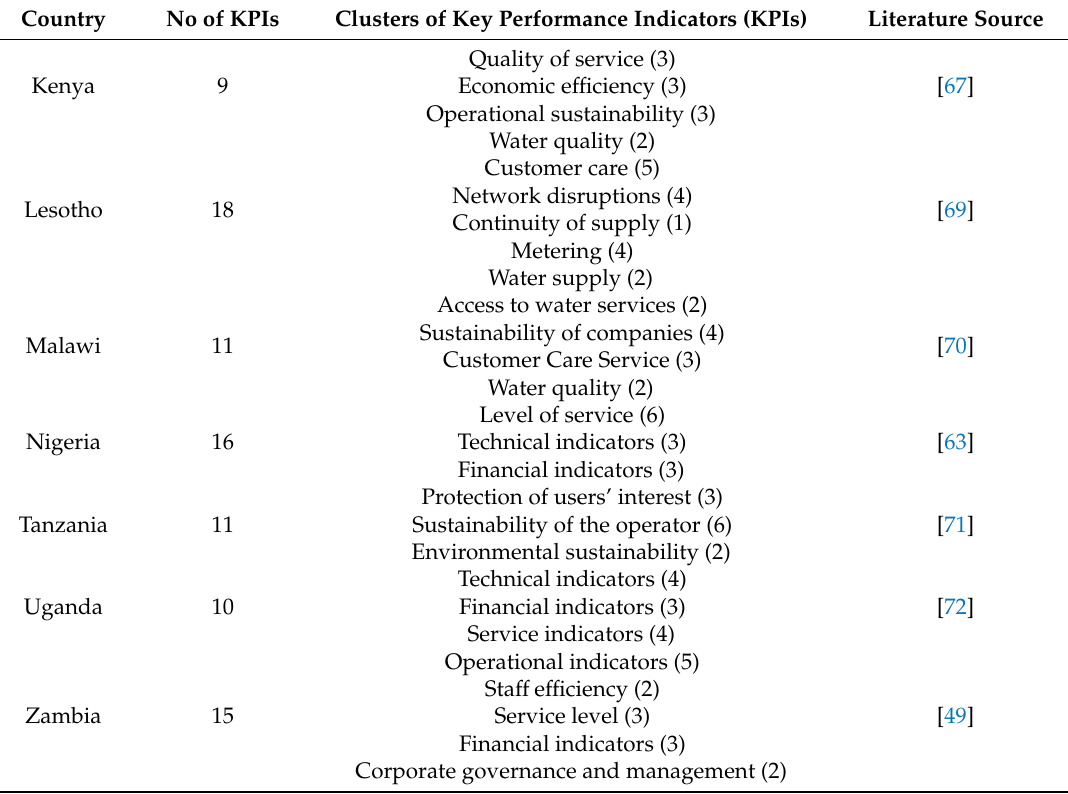
Table 2. Summary of clusters of Key Performance Indicators (KPIs) for assessing the water service performance in selected countries; number of KPIs within cluster in